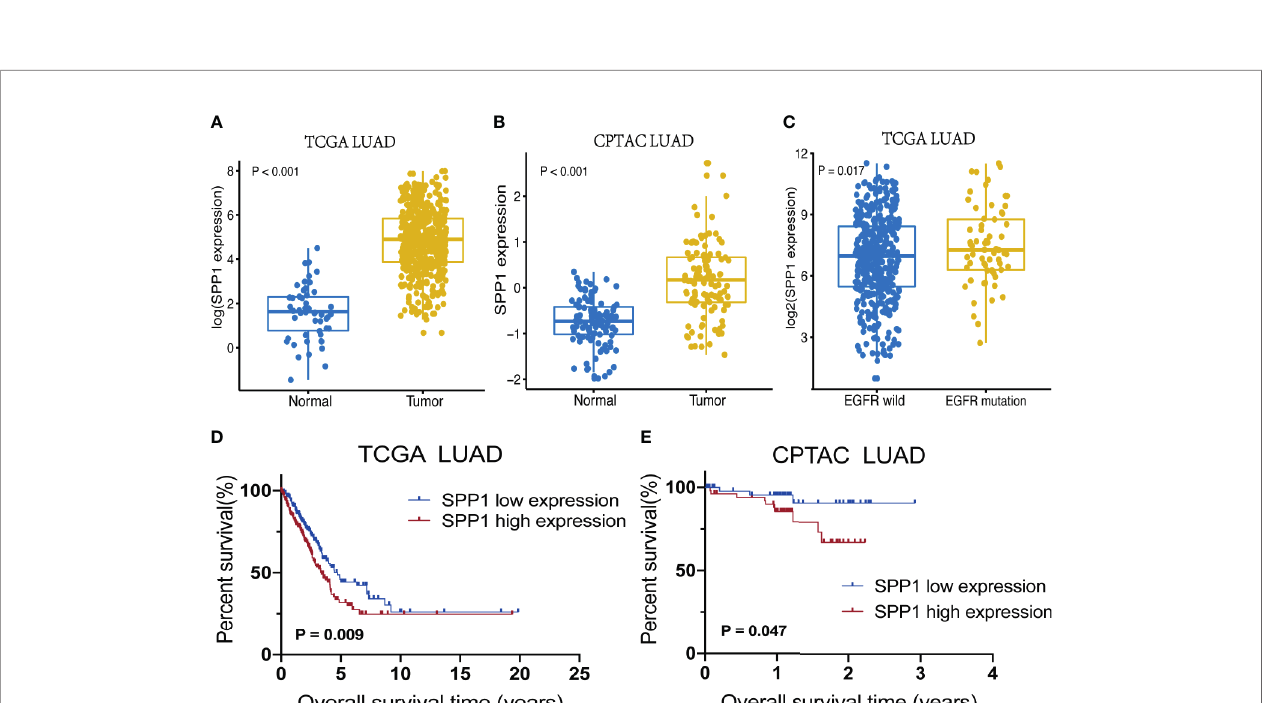
FIGURE 2 | SPP1 expression differences and survival outcomes in LUAD. (A) SPP1 RNA expression levels in Normal vs . Tumor samples. (B) Expression of SPP1 protein in Normal vs . Tumor samples. (C) SPP1 RNA expression in EGFR wild-type vs . EGFR mutant samples. (D) Kaplan – Meier survival curves for high and low SPP1 expression groups in TCGA. (E) Kaplan – Meier survival curves for high and low SPP1 expression groups in CPTAC.